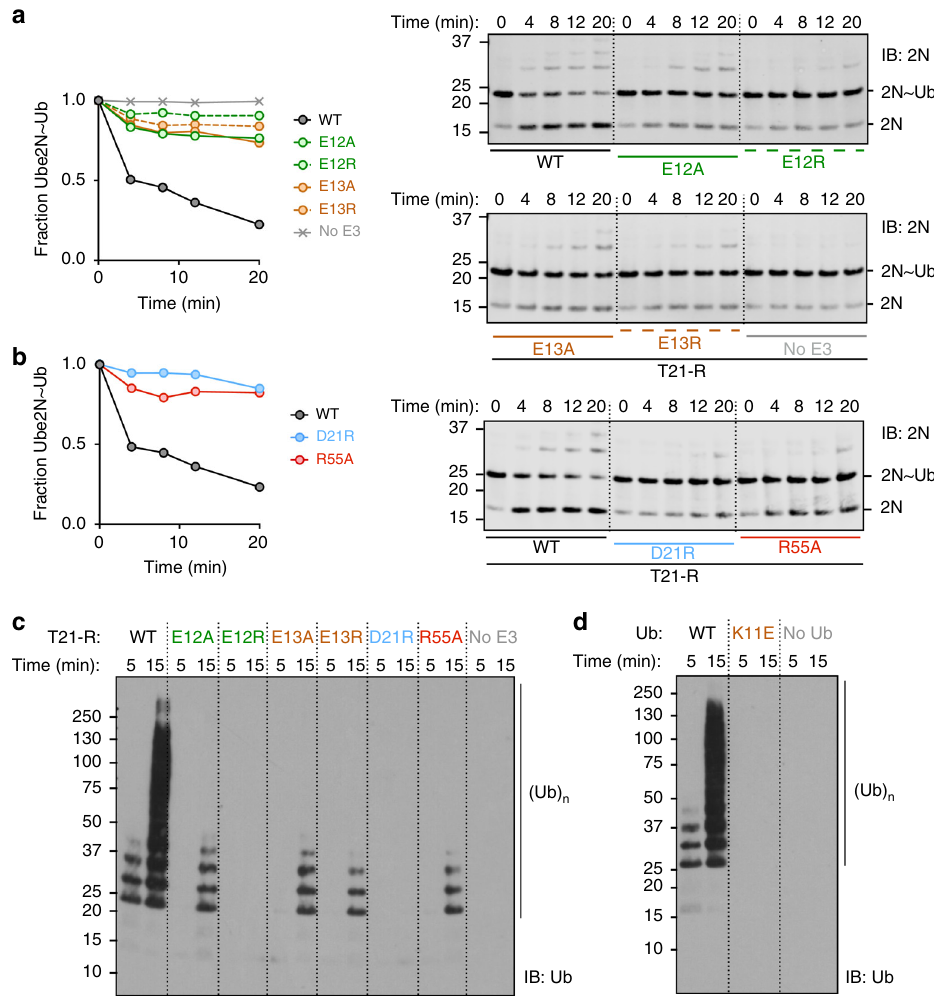
Fig. 4 The tri-ionic anchor points are essential for K63-ubiquitination in vitro. Catalysis of ubiquitin discharge from ubiquitin-conjugated Ube2N/Ube2V2 by a TRIM21 di-glutamate and b D21R, R55A mutants. Catalysis of unanchored ubiquitin chains by Ube2N/Ube2V2 of c T21-R mutants and d ubiquitin K11E. All biochemical assays were performed in at least two independent experiments. Source data are provided as a Source Data fi A sequence alignment of the E2 enzymes identi fi ed in our screen to interact with TRIM21 shows that the charged residues in Ube2N that are coordinated by E12 and D21 are not conserved (Fig. 5a). Ube2N residue R14, which interacts with E12 is an